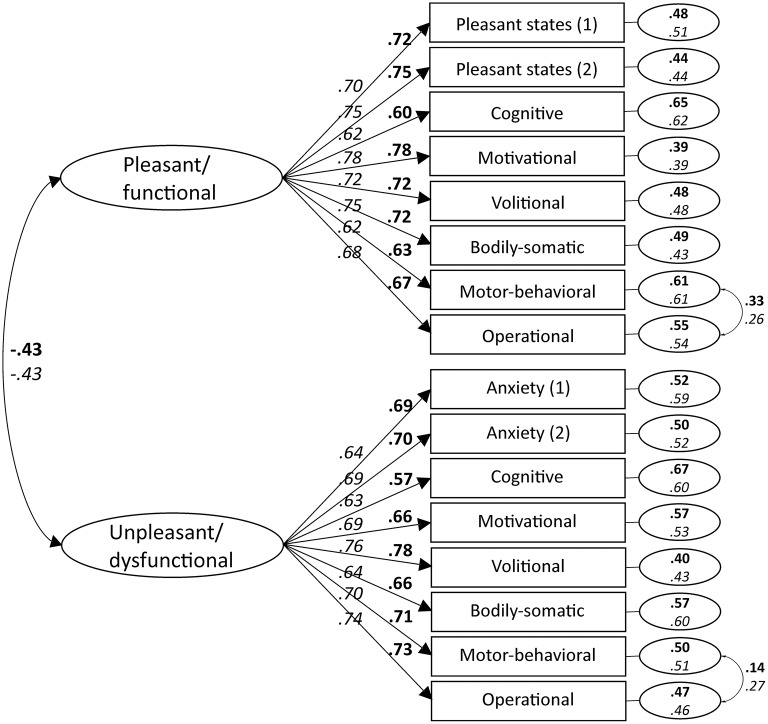
Standardized factor loadings, error variances, and correlations between latent constructs of the 16-item PBS-SPE scale derived from Study 1 (bold; N = 1,014) and Study 2 (italic; N = 1,011) based on confirmatory factor analyses. All factor loadings are significant at p < 0.001 (two-tailed).